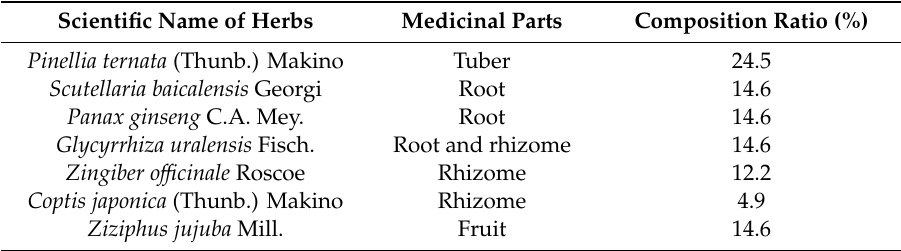
Table 1. The herbal ingredients and composition ratio of banhasasim-tang